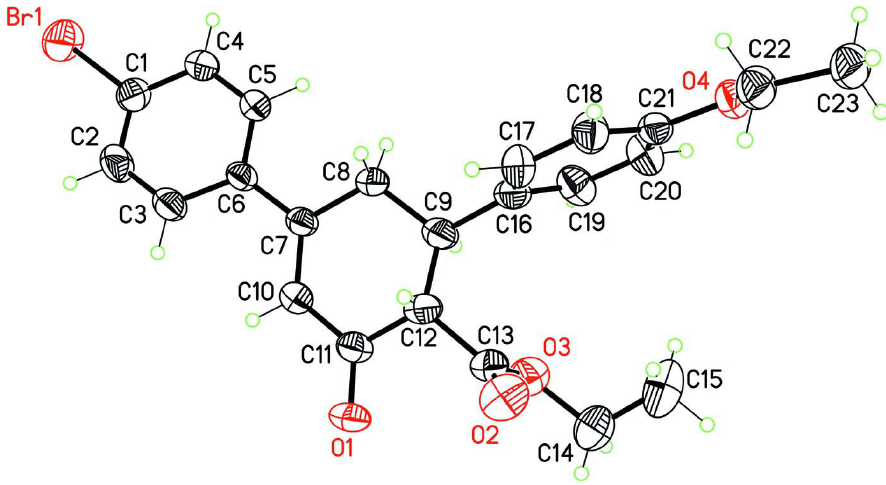
Figure 1 The title molecule with the atom labeling scheme. The displacement ellipsoids are drawn at the 30% probability level and H atoms are shown as small spheres of arbitrary